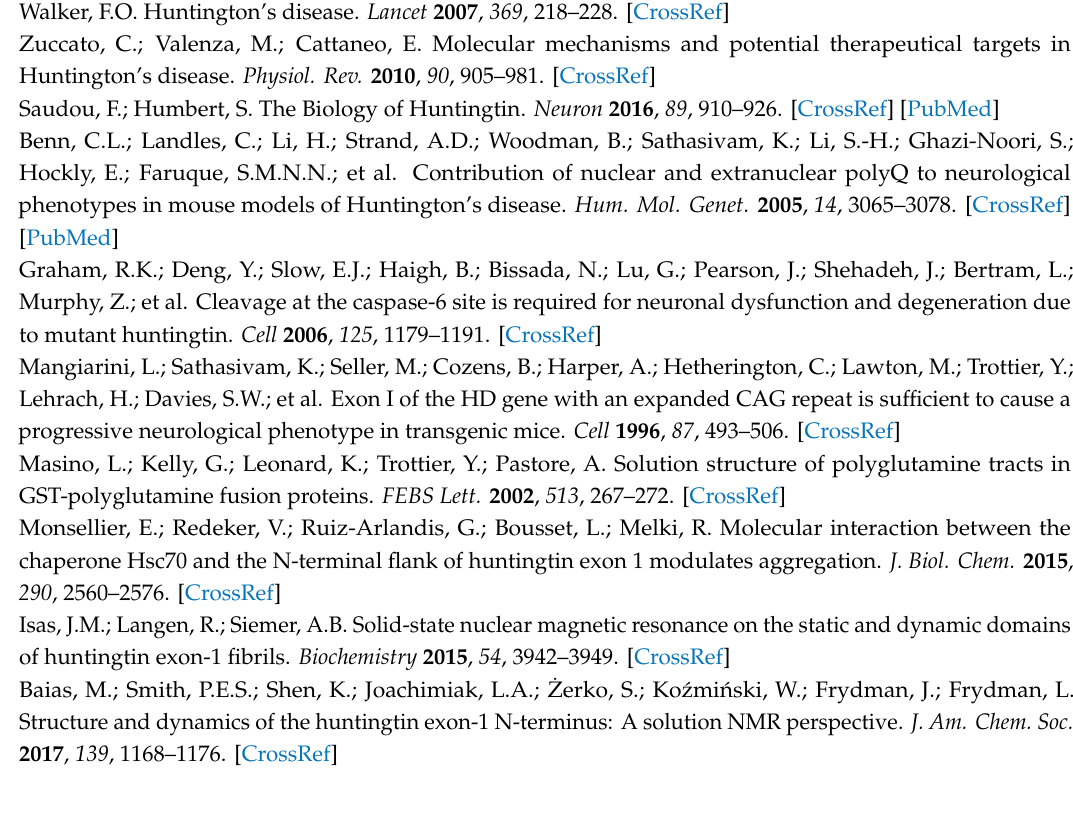
Figure S1: E ff ect of EF-Tu on Gln-tRNA CUA stability and CF HttEx1